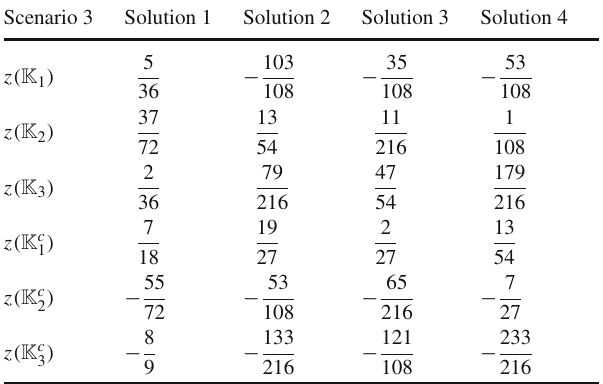
Table24 Valuesofthe U ( 1 ) (cid:2) chargesfortheexoticquarksinU μν SSM models using solution (29) with the hypercharges of Table 4. For each column, the U ( 1 ) (cid:2) charges of the rest of the fields are given in Table 2 and Scenario 3 of Table 3. The minimal number of singlets under the SM gauge group consistent with these charges is n ν c = 3 , n S = 2 , n N = 1 and n ξ = 2